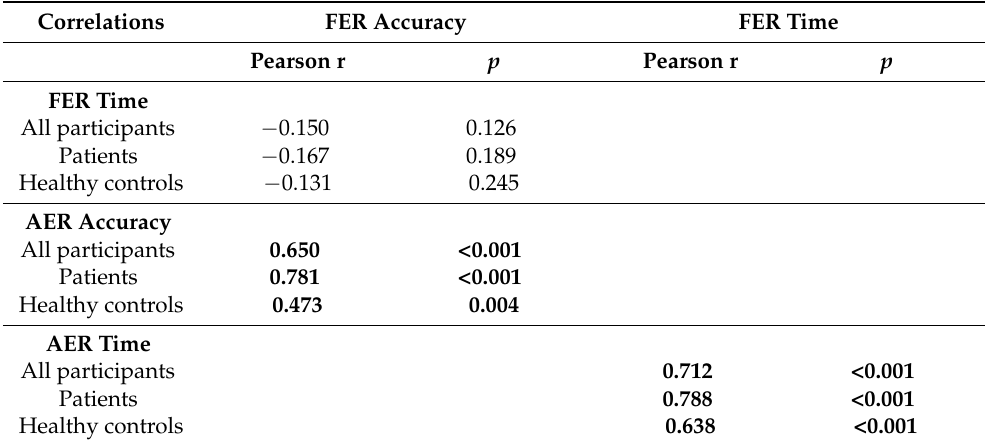
Table 2. Correlations between facial emotion recognition (FER)-accuracy/time, and auditory emotion recognition